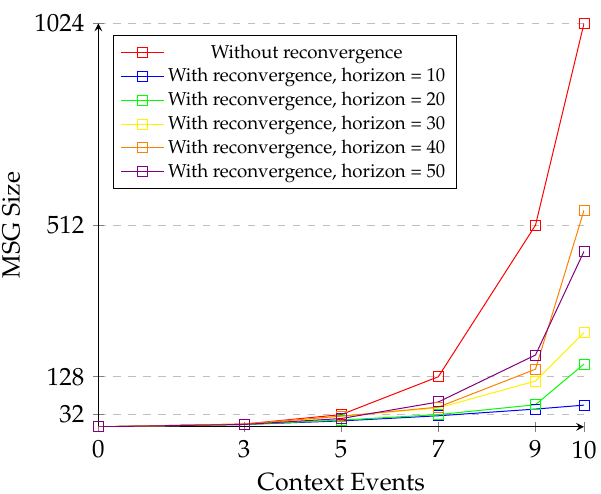
Figure 6. MSG with reconvergence for 80 jobs.